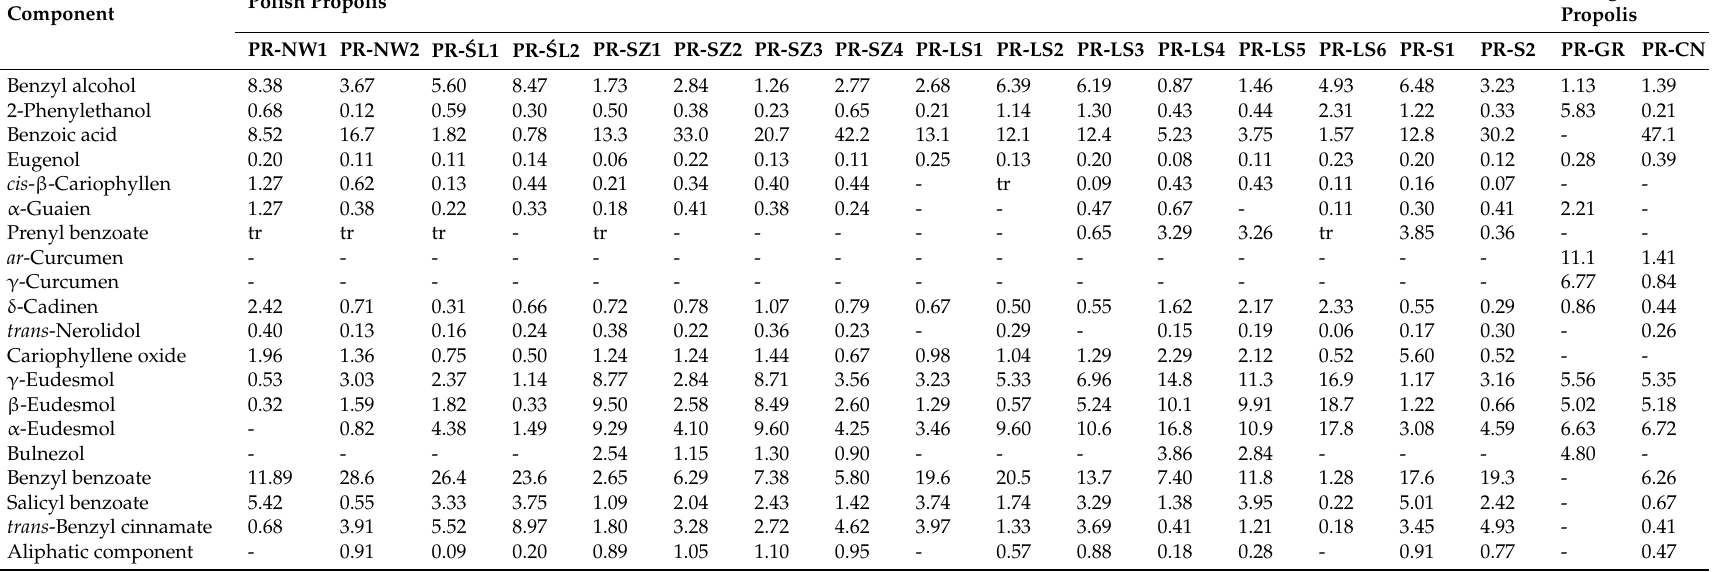
Table 2. Main components of propolis essential oils